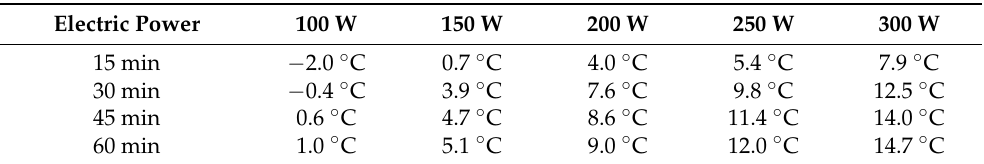
Table 3. The heater temperatures during heating for 15, 30, 45, and 60 min according to the electric power change.